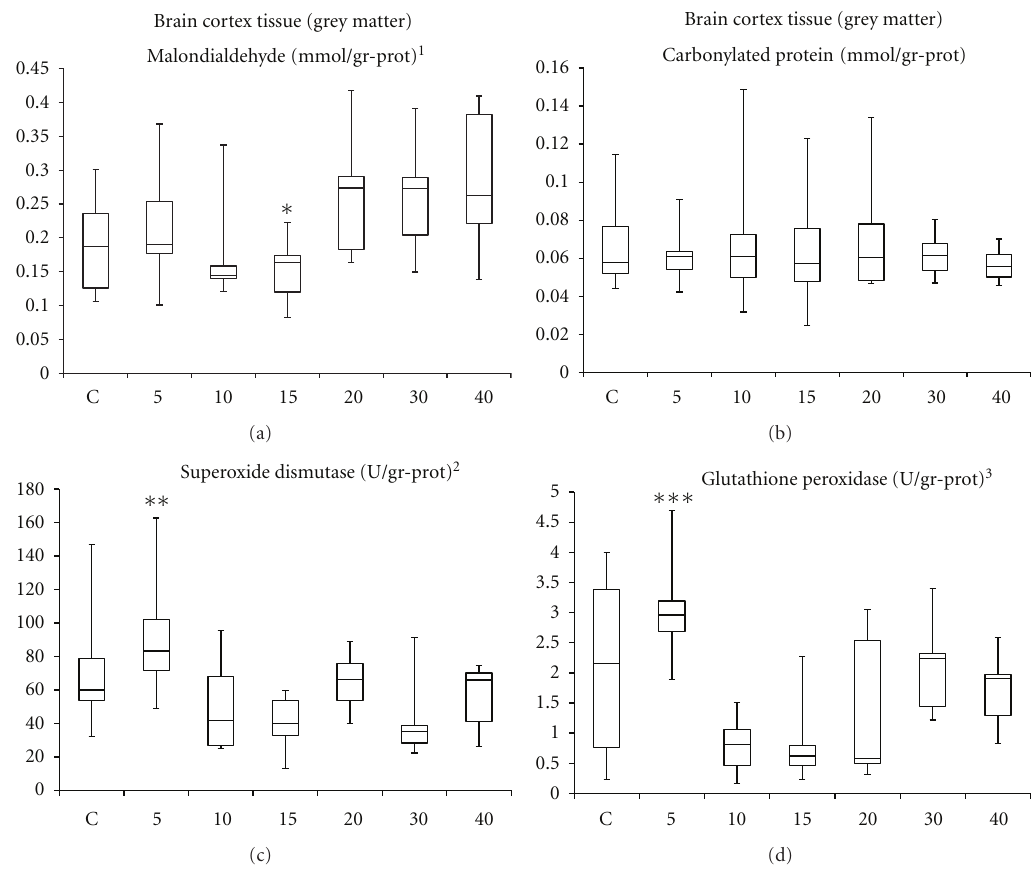
Figure 1: Oxidation products and antioxidant enzymes in brain cortex tissue. C: control group; numbers on the x -axis stand for the HBO 2 session number of the groups. One-way ANOVA : 1 P = 0 . 016; 2 P = 0 . 005; 3 P < 0 . 001. Bonferroni : ∗ P = 0 . 047 versus 40-session group; ∗∗ P = 0 . 013 versus 15-, and P = 0 . 012 versus 30-session groups; ∗∗∗ P < 0 . 001 versus 10-, P = 0 . 001 versus 15-, and P = 0 . 043 versus 20-session HBO 2 groups. Note that no significant changes for any measured parameters were recorded in comparison with the control